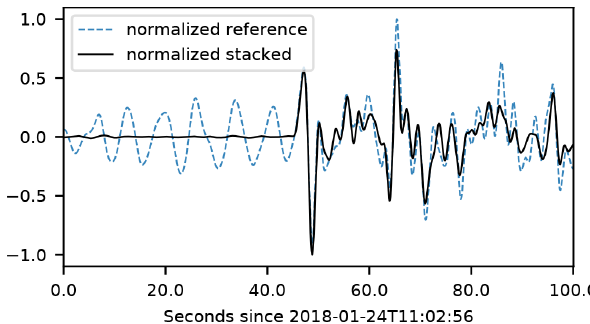
Figure 4. Stacking example for M 6 . 1 earthquake in Hokkaido, Japan, on 24 January 2018. Out of a total of 746 stations with a cross-correlation coefficient > 0 . 8 to the reference trace CH.PANIX (blue line), 450 are stacked onto each other (black line). The first motion that was poorly resolvable on the reference trace can be clearly identified on the stacked trace, as the signal-to-noise ratio increased by a factor of 30 in the stacking process. Both traces are normalised for comparison and filtered between 0.03 and